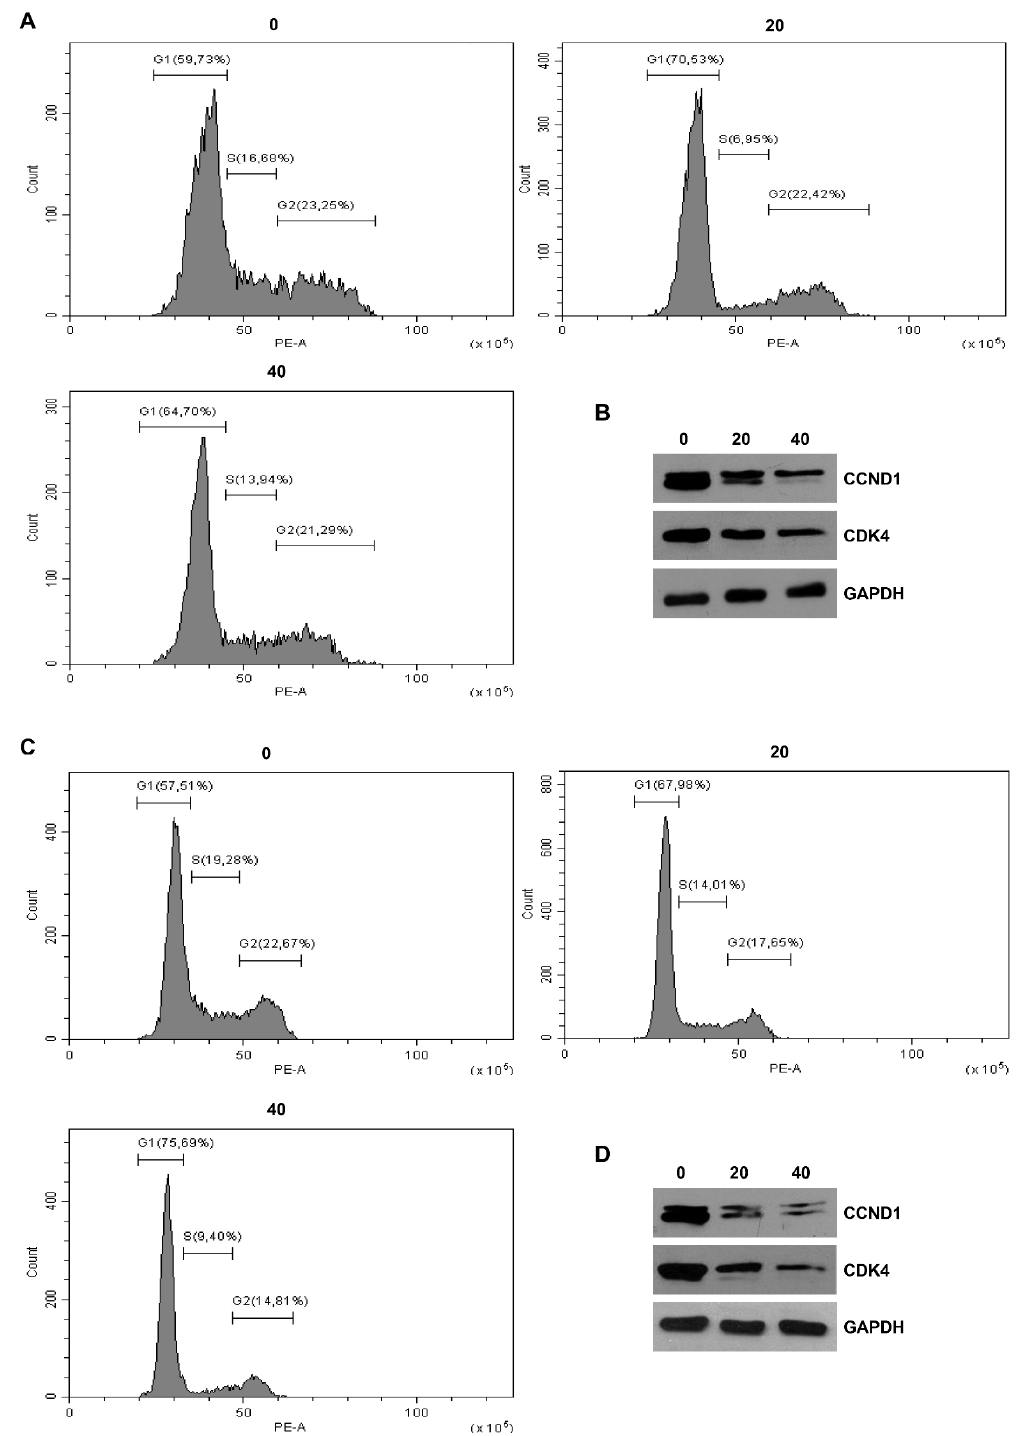
Figure 4. Effects of derivative 2 on the MCF7 and MDA-MB231 cell cycle distribution. ( A , C ) MCF7 ( A ) and MDA-MB231 ( C ) cells were synchronized in serum-free media for 12 h and then exposed to vehicle (0) or derivative 2 for 24 h at different concentrations (20 and 40 µ M). The distribution of MCF7 and MDA-MB231 in the cell cycle was determined by flow cytometry using propidium iodide stained nuclei. ( B , D ) Western blot analysis of CCND1 and CDK4 was performed on equal amounts of total proteins extracted from MCF7 ( B ) and MDA-MB231 ( D ) cells treated with derivative 2 (20 and 40 µ M) for 24 h. Blots are representative of three independent experiments with similar results. GAPDH was used as a loading